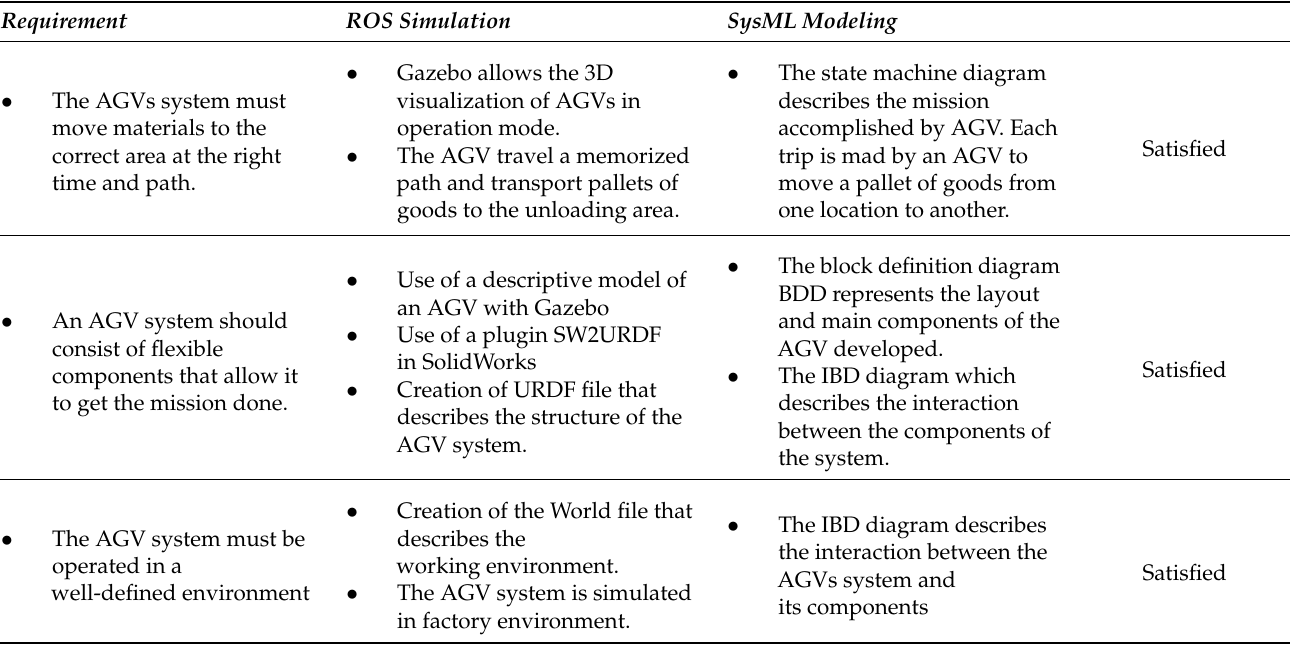
Table 1. System satisfaction with initial